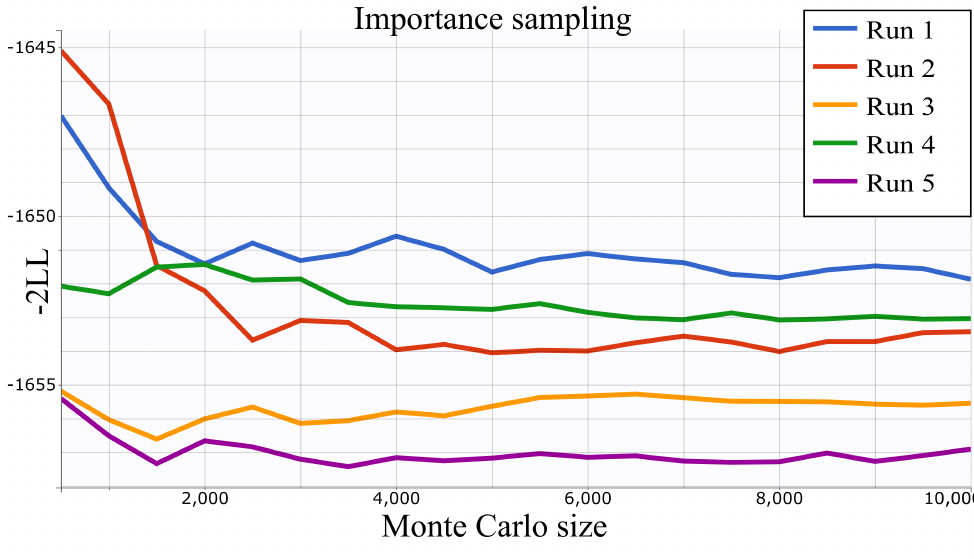
Figure 10. Distribution of the − 2LL values for each iteration among all the five